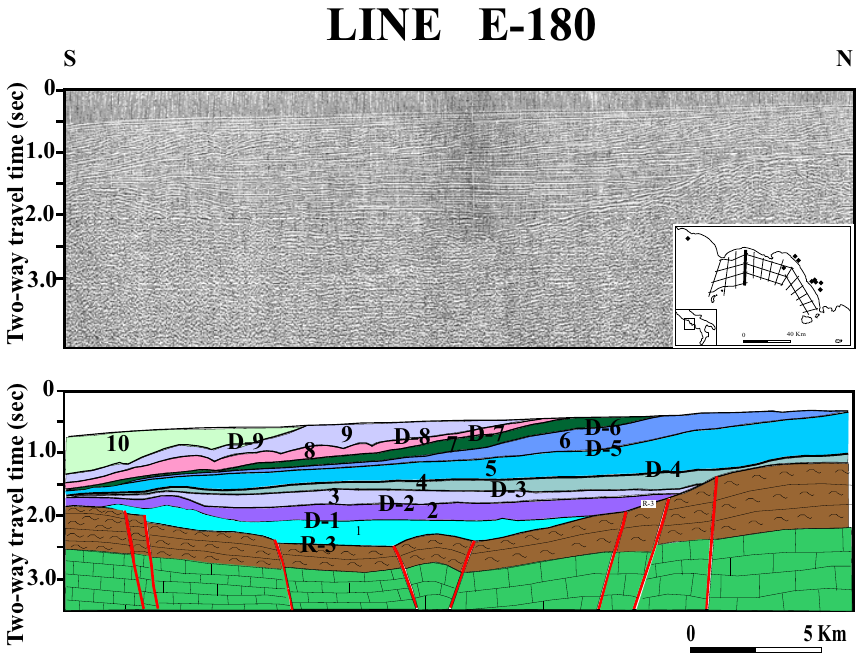
Figure 5. E180 seismic profile (re-interpreted from Aiello et al. [2000]), showing the stratigraphy of the Terracina Basin. Ten seismic sequences are bounded by regional unconformities that correspond to on-lap and/or down-lap surfaces, and, in the upper part of the basin fill, to erosional truncations. Regional unconformities: R-3, D-1, D-2, D-3, D-4, D-5, D-6, D-7, D-8, D-9). Seismic sequences: 1, 2, 3, 4, 5, 6, 7, 8, 9 and 10. The lower group of seismic sequences (1-4) shows seismic facies with parallel reflectors on-lapping the top of the acoustic basement and appears locally involved by normal faulting, testifying a synsedimentary nature of these strata. The reflector D4 represents a tectonically-enhanced unconformity, which marks the beginning of the progradation in the basin fill, as seen by five prograding seismic sequences